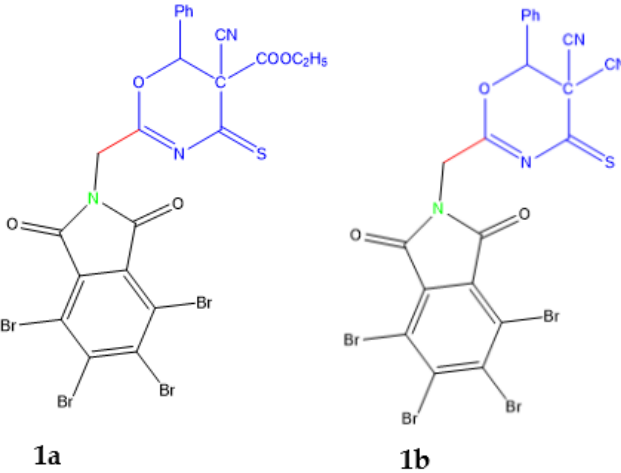
Figure 1. Compounds 1a and 1b are indexed by Magda et al.